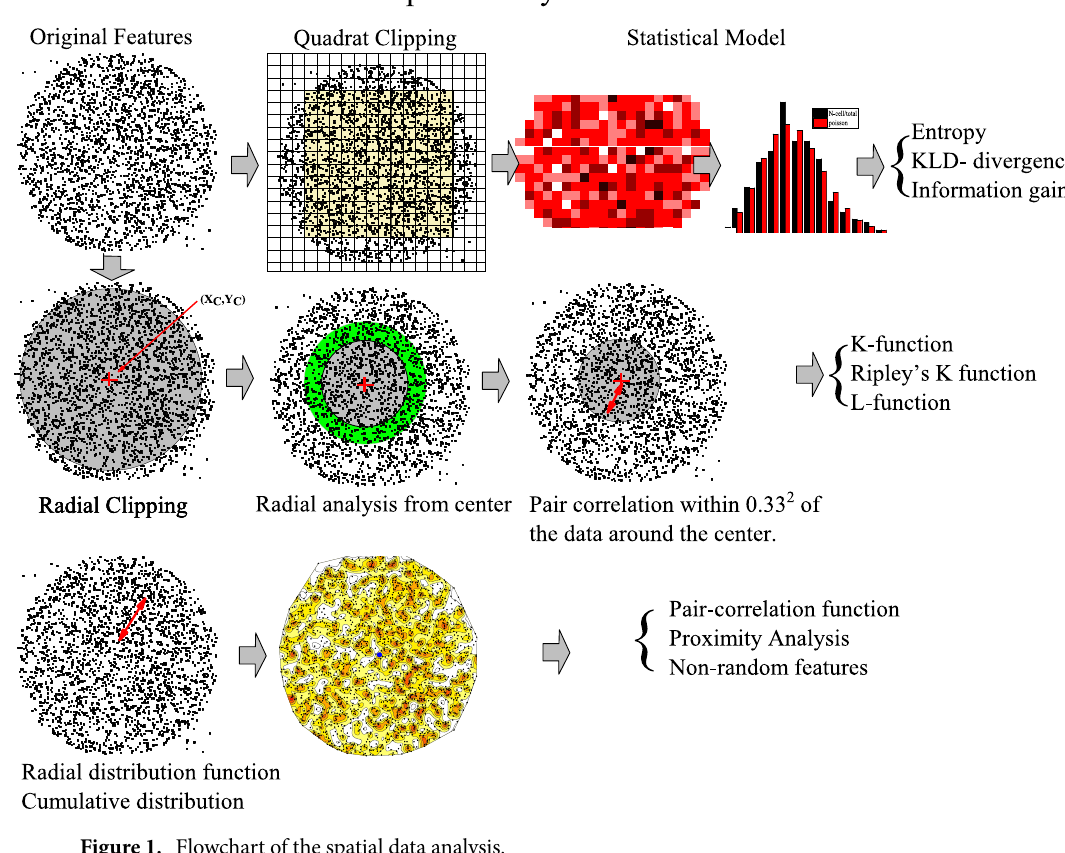
Figure 1. Flowchart of the spatial data